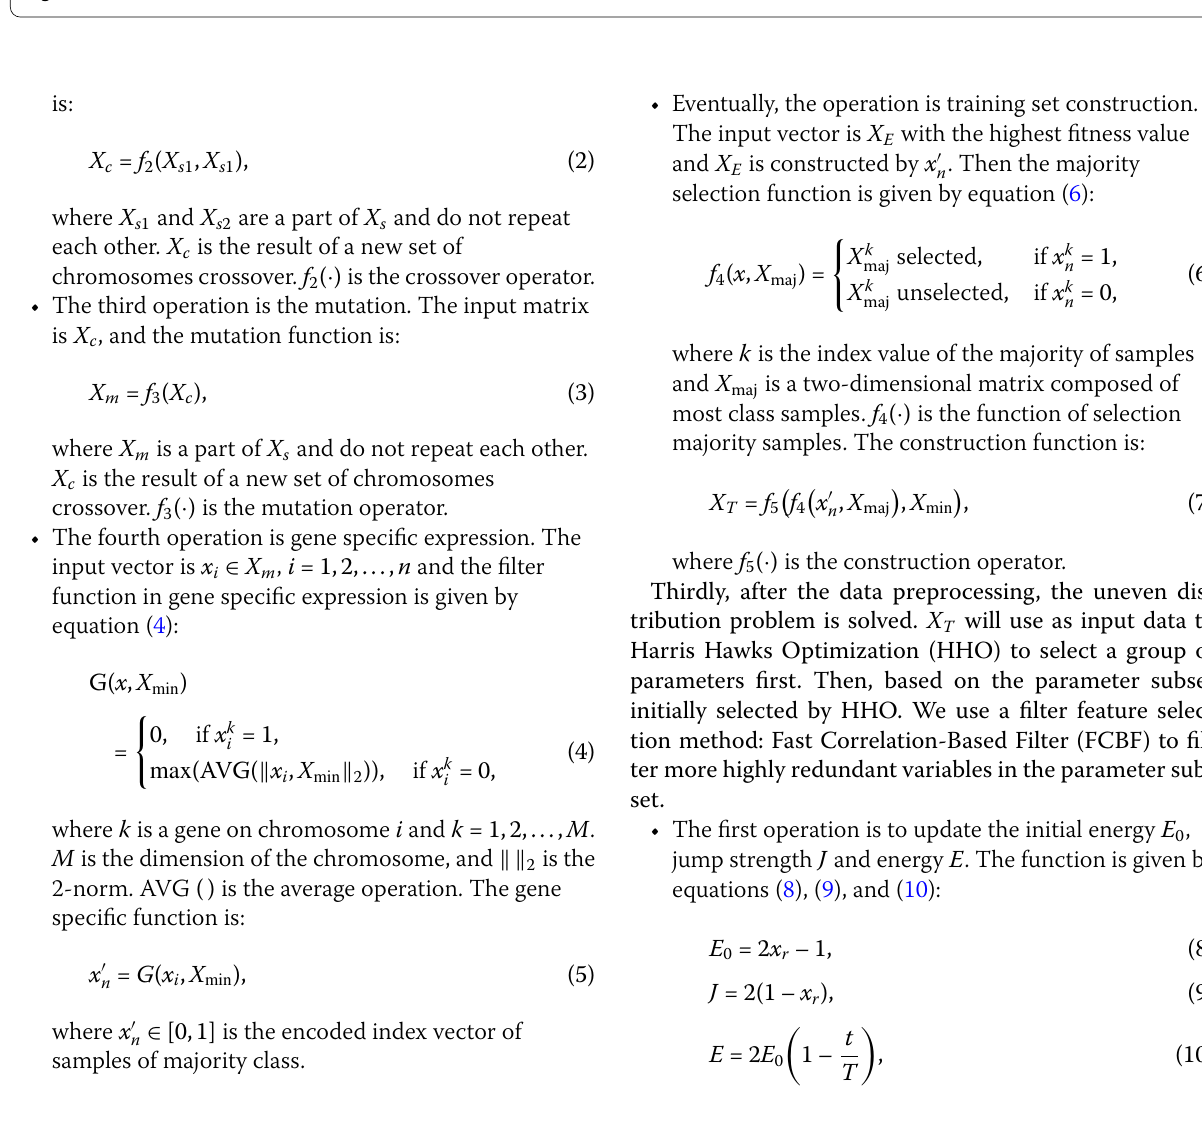
Figure 2 Prediction